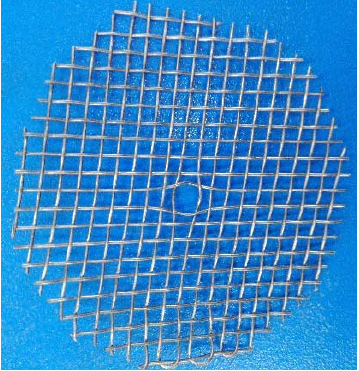
Figure 14. Wire mesh piece .